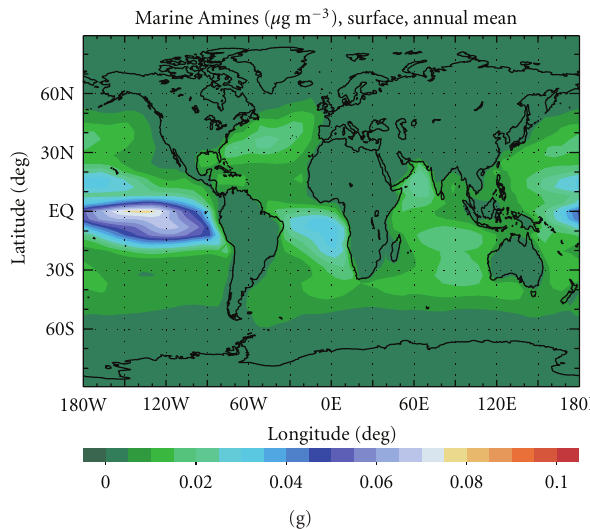
Figure 2: Annual mean surface distributions of (a) mass fraction of Marine OA to submicron sea-spray aerosol (in percent) calculated based on Chl-a as described by Vignati et al. [34]; (b) sea-salt in the accumulation mode; (c) Marine POA; (d) total marine SOA (from MS − , isoprene and monoterpenes); (e) SOA from marine isoprene and monoterpenes; (f) SOA from MS − , (g) SOA from marine Amines. Aerosol components are given in μ g m − 3 , except for SOA from marine isoprene and monoterpenes which is given in ng m − 3 .